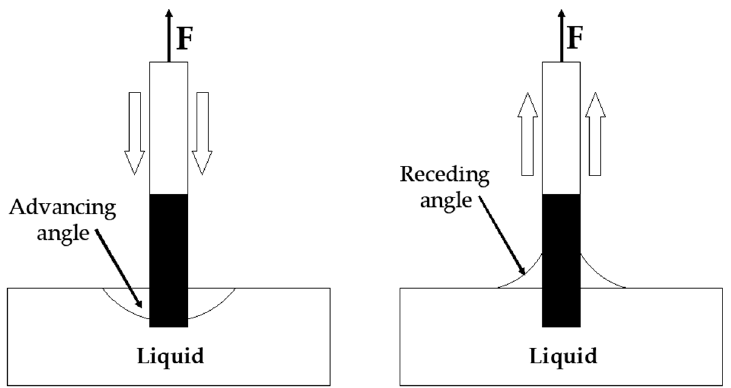
Figure 1. Schematic illustration of Wilhelmy plate technique [35].